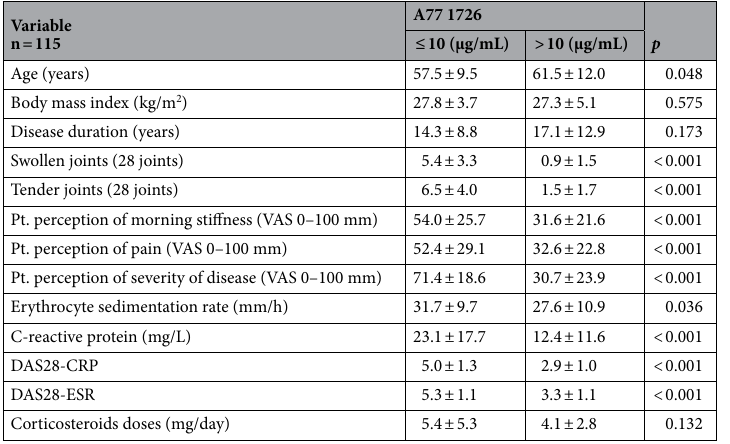
ence between RA patients who achieved low-disease activity or remission (DAS28-ESR ≤ 3.2) and between age, BMI, RA disease duration, and corticosteroid dosage (data not depicted in a table).